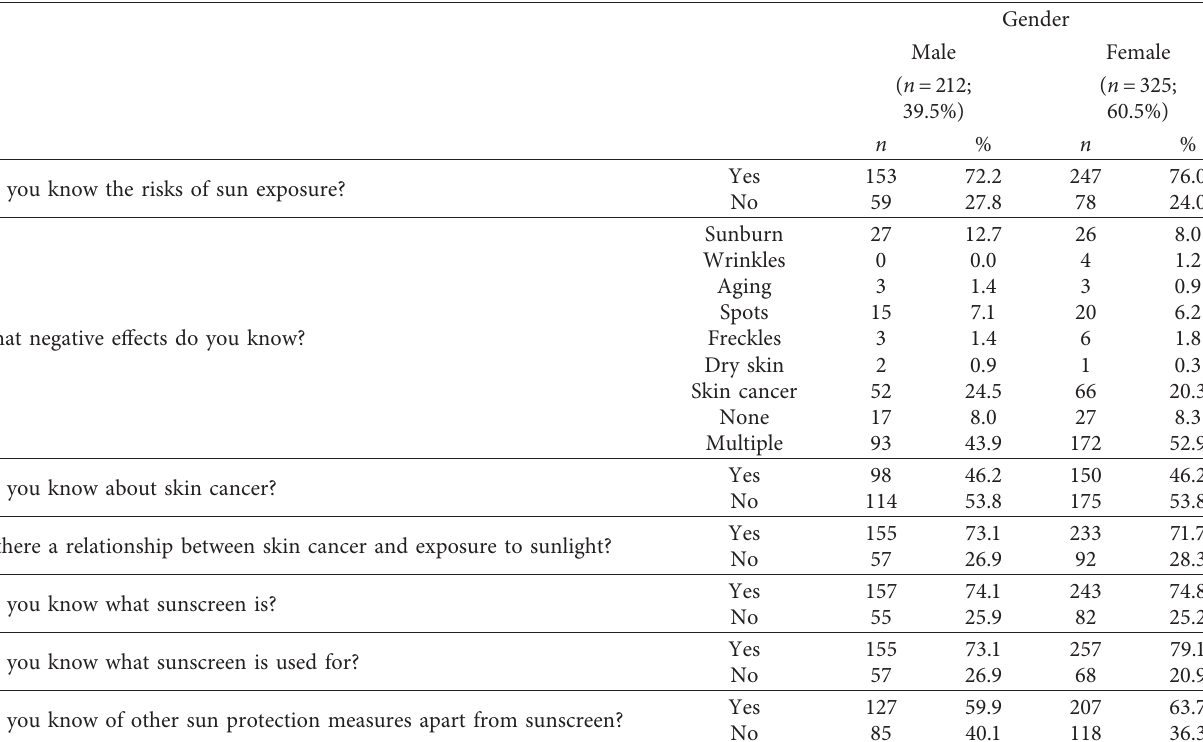
Table 2: Knowledge questionnaire of skin